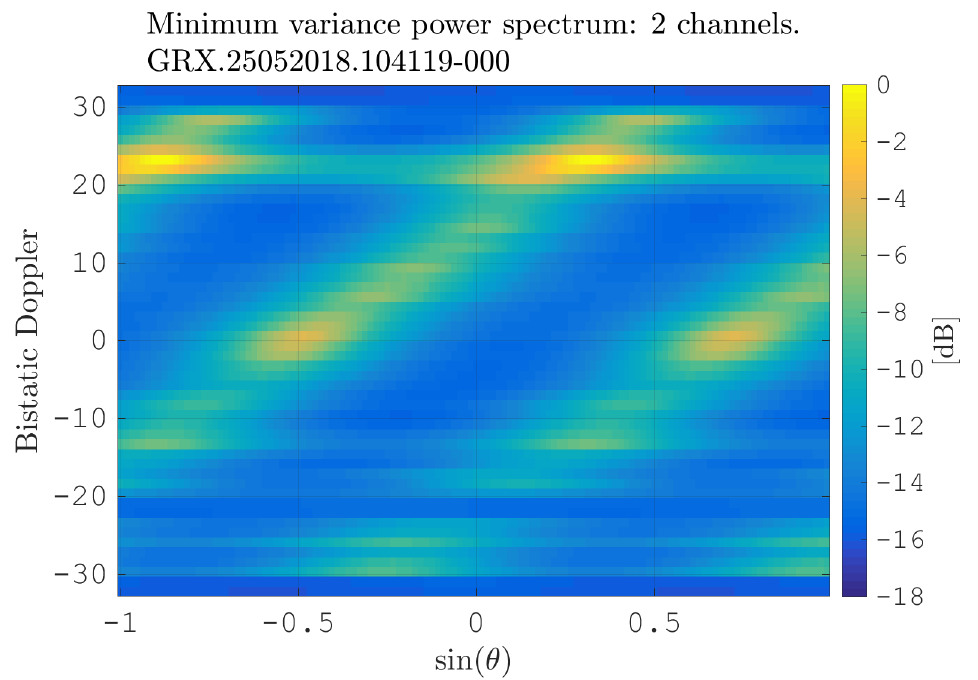
Figure 10. Minimum variance power spectrum of the data at the beginning of the processing chain.